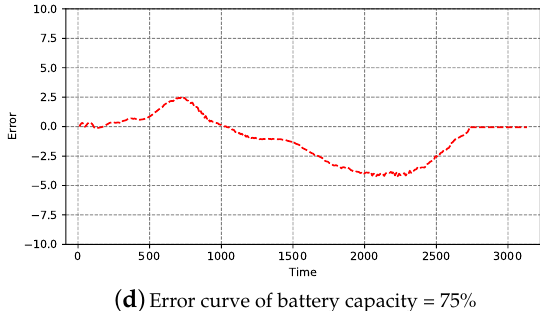
( c ) SOC estimation curve at battery capacity = 75% ( d ) Error curve of battery capacity = 75%